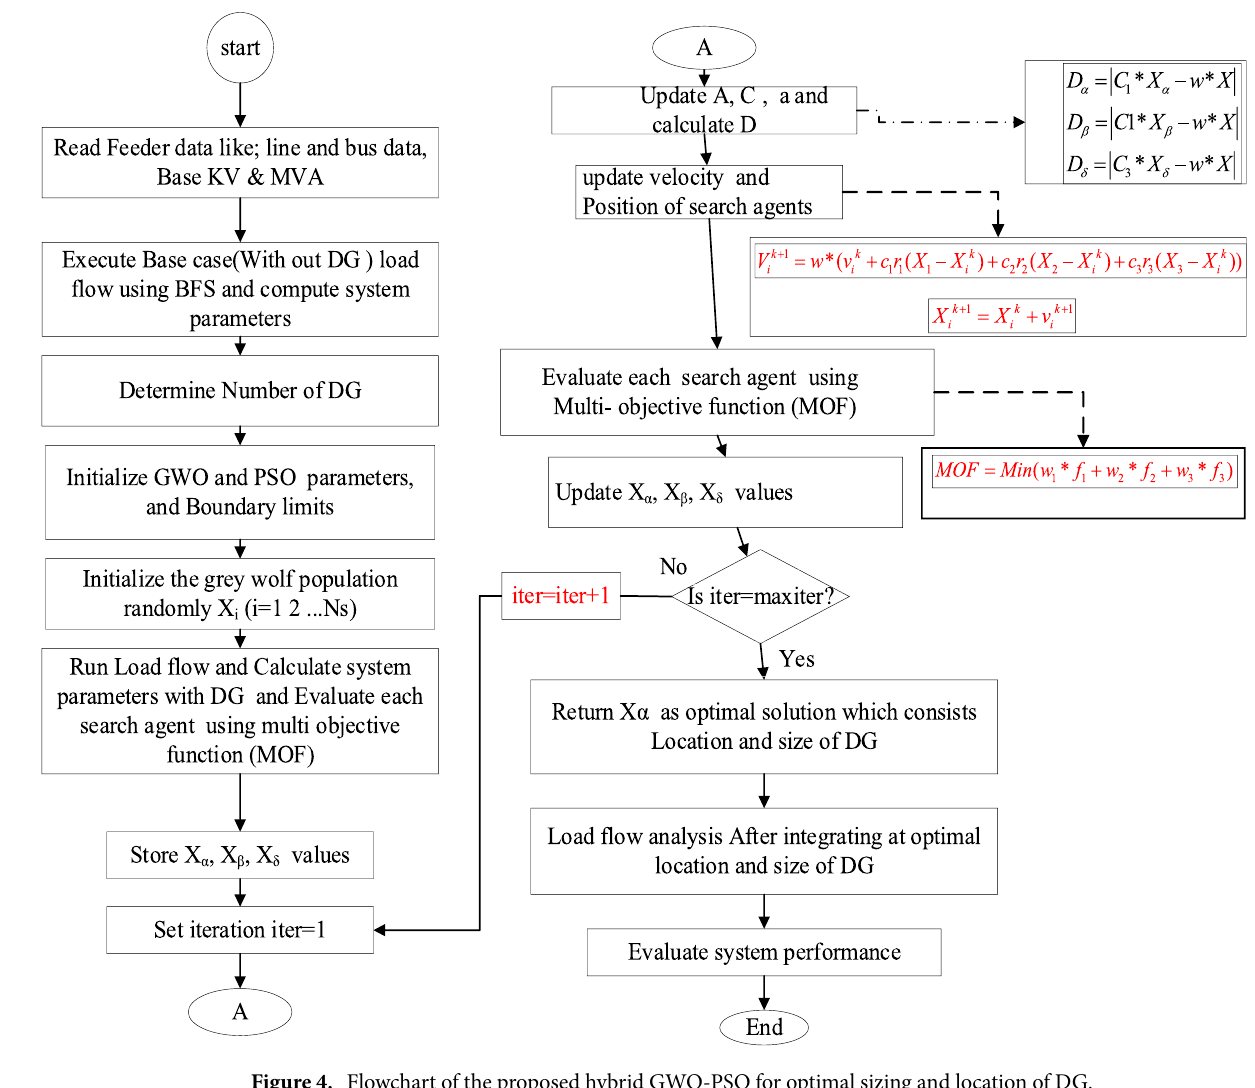
Figure 4. Flowchart of the proposed hybrid GWO-PSO for optimal sizing and location of DG.